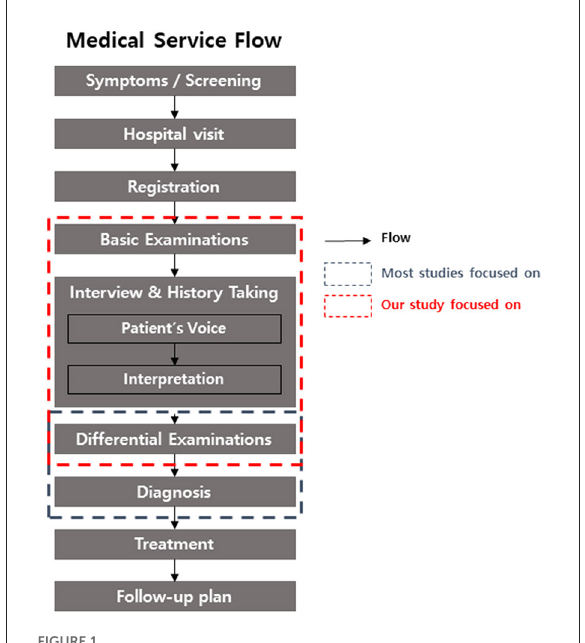
FIGURE1 The flow of medical services from to doctors in this